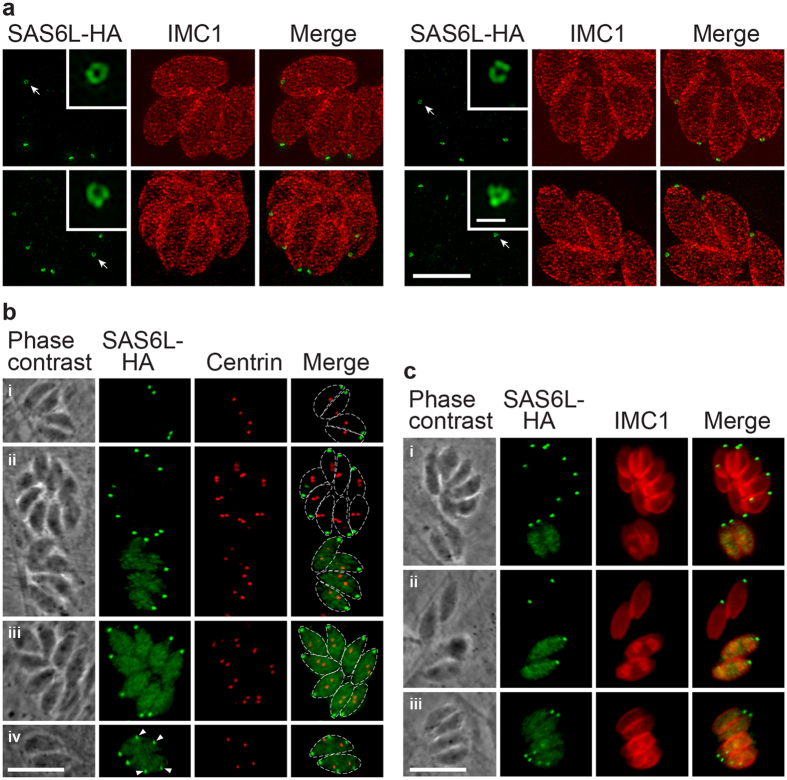
SAS6L location and behaviour throughout the tachyzoite cell cycle in Toxoplasma gondii.T. gondii expressing endogenous SAS6L with C-terminal fusion to HA-APEX fixed in host vacuoles and stained for HA (green) and either IMC1 (red, a and c) or centrin (red, b) (a) 3D-SIM super-resolution images with cell apices facing the viewer showing SAS6L rings (arrows, insets) and apices in profile showing SAS6L flush with the apical IMC. (b) Widefield images of parasites at different points of the cell cycle indicated by centrosome number and position (stained for centrin): interphase with single centrosome per cell (i); newly divided centrosomes close together (ii, upper vacuole); divided centrosomes migrated further apart (ii, lower vacuole; and iii); cells with nascent apical complexes (iv, arrowheads). (c) Widefield images of parasites showing daughter pellicle formation (stained for IMC1): before daughter pellicle formation (i and ii, upper vacuoles); small pellicle cups (i and ii, lower vacuoles; iii, upper vacuole); mid pellicle development (iii, lower vacuole). Scale bars = (a) 5 μm and 500 nm (inset); and (b,c) 10 μm.